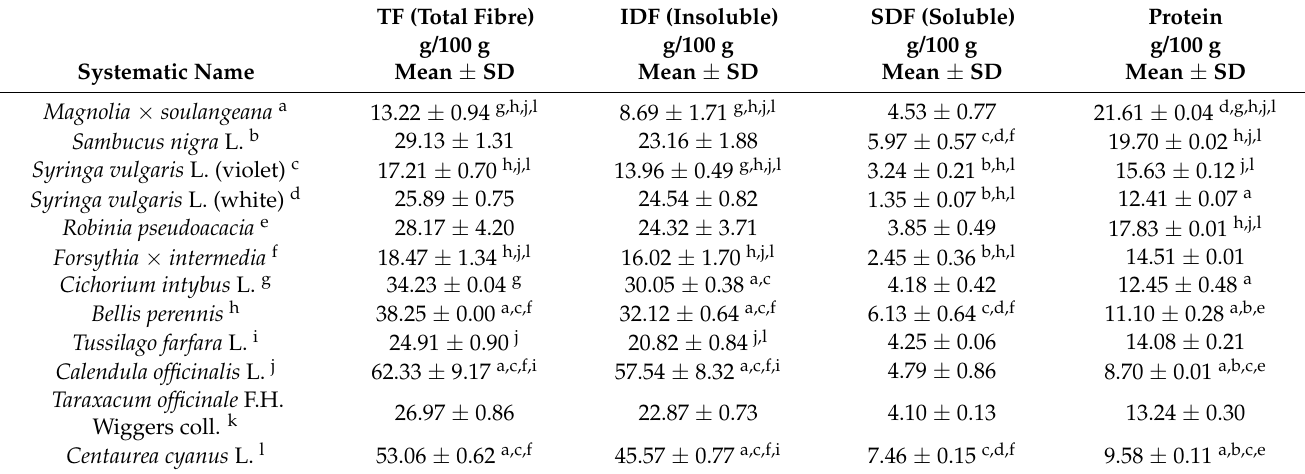
Table 2. The content of dietary fibre (total, soluble and insoluble fractions) and total protein in edible